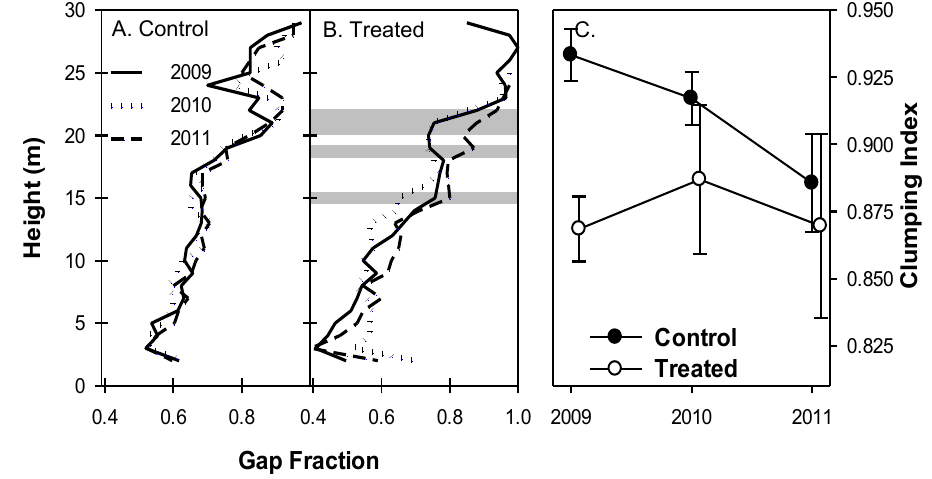
Figure 2. Canopy gap fraction in control plots. ( A ) shows no significant increases from year to year, but gap fraction in the upper canopy of treated plots. ( B ) increased from 2009 to 2011. Standard error bars and 95% confidence intervals overlap substantially (not presented) in unshaded areas. Among-plot variability of clumping index ( C ) increased in treated plots with time but was not different from control plots in 2010 or 2011. Standard error bars represent between-plot variation.